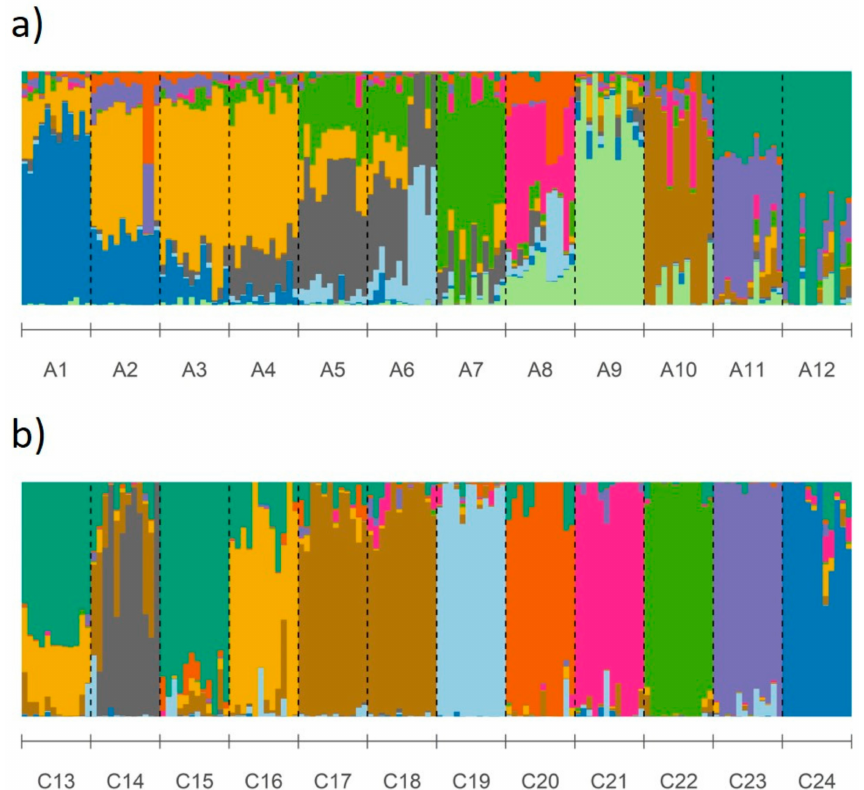
Figure 4. STRUCTURE plots for identified optimal number of genetic clusters for ( a ) Astartea leptophylla (K = 11) and ( b ) Callistachys lanceolata (K = 10), with each color representing a genetic